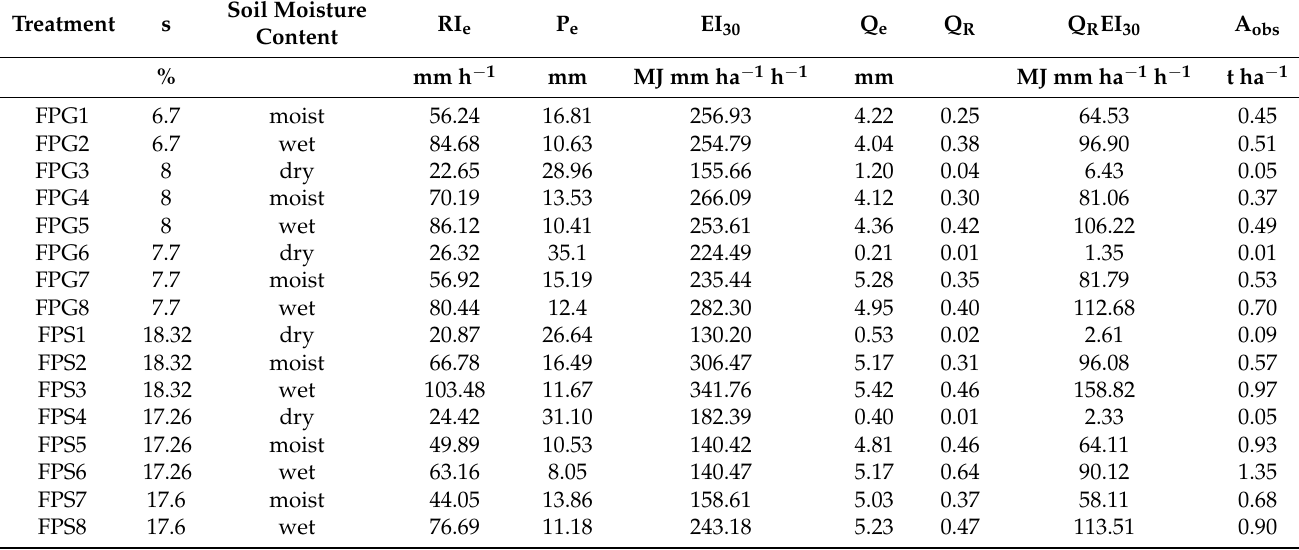
Table A1. Summary of the different individual rainfall, runoff and soil loss